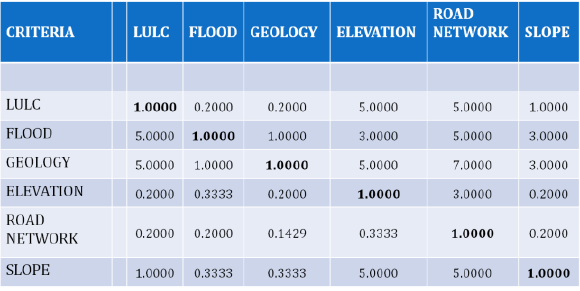
Table 2: Pair wise comparison matrix- expert opinions